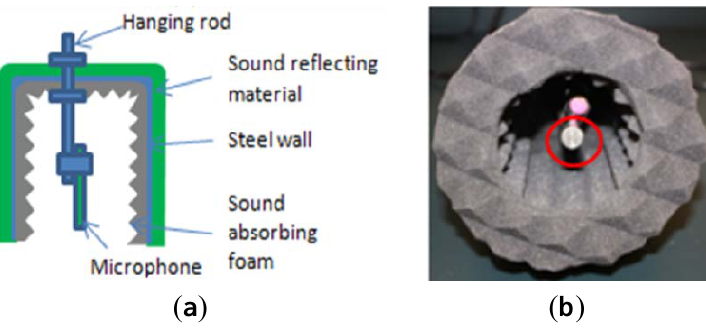
Figure 5. De-noise sound enclosure for microphone. ( a ) The schematic design of sound enclosure. ( b ) Built-up sound enclosure.